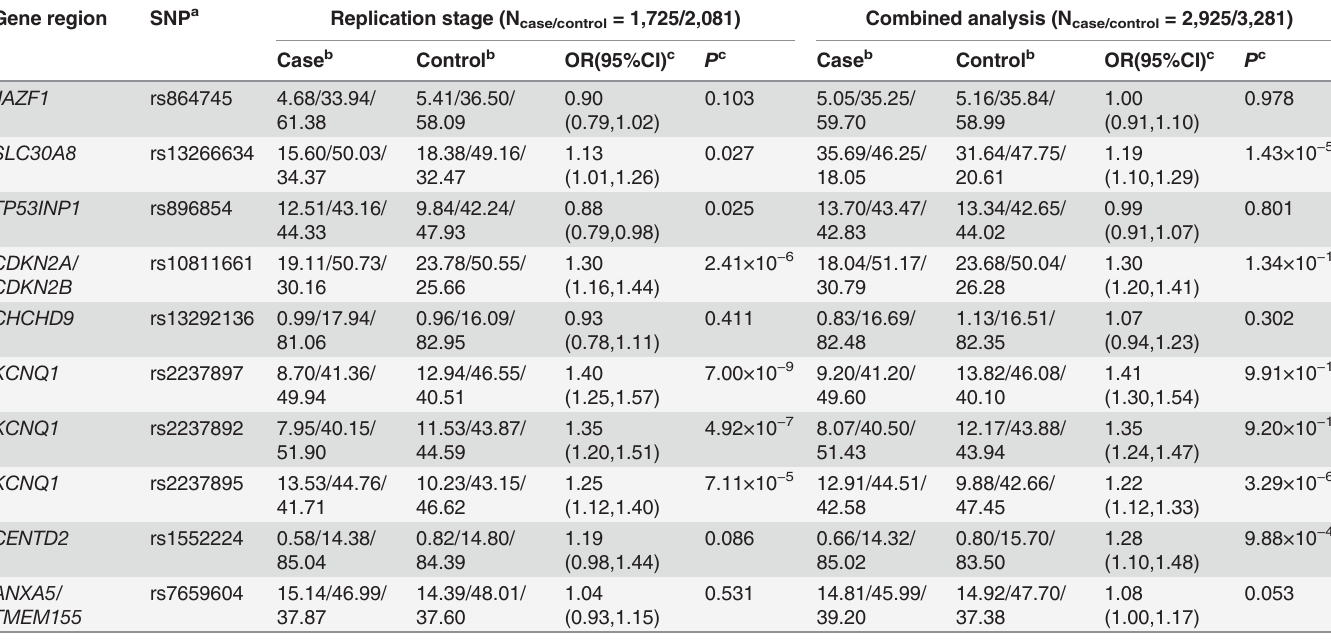
Table 2. Association between 10 suggestive SNPs and type 2 diabetes in the replication stage and combined analysis. Gene region